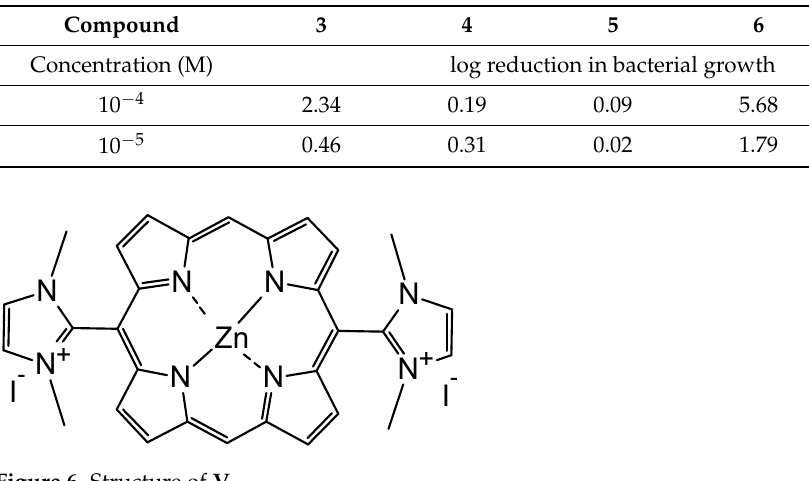
Figure 6. Structure of V . Table 3. Photodynamic activity of the studied phthalocyanines against Staphylococcus aureus upon excitation with red light at the dose of 30 J/cm 2 .